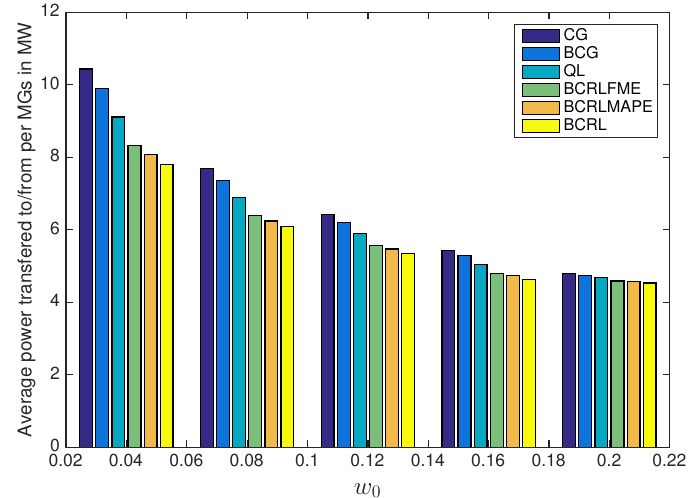
Figure 7. The average energy transfer with macrogrid versus virtual cost weighting parameter w 0